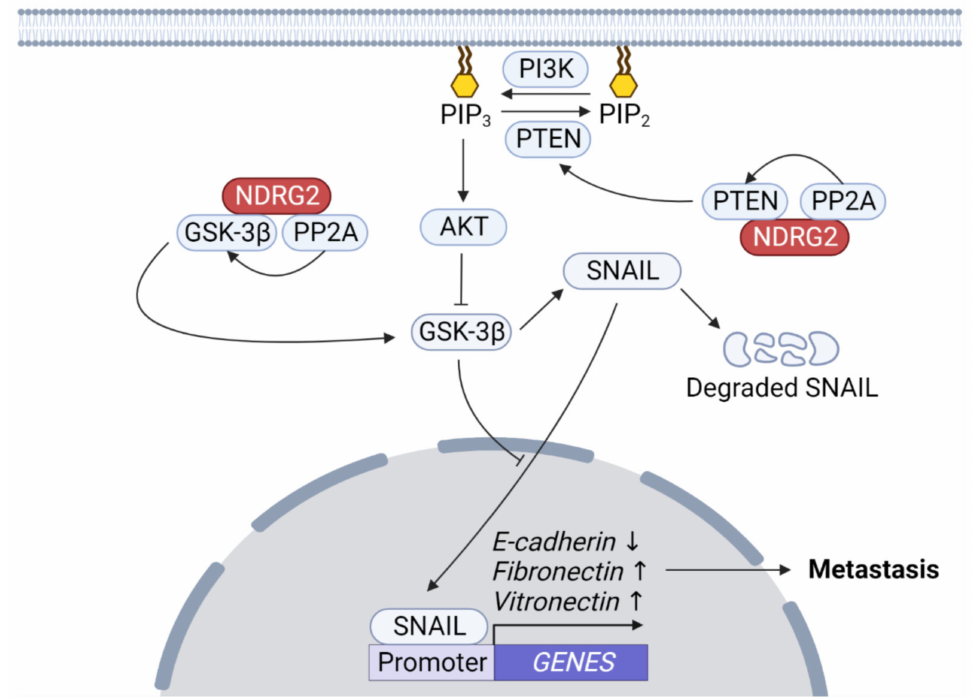
Figure 5. NDRG2–PP2A-mediated GSK-3 β activation. AKT induces inhibitory phosphorylation of glycogen synthase kinase-3 beta (GSK-3 β ). The NDRG2–PP2A complex recruits PTEN, which dephosphorylates PIP3 to inhibit AKT activation. Further, the NDRG2–PP2A complex releases the inhibitory phosphate of GSK-3 β to activate it. Active GSK-3 β phosphorylates SNAIL to induce β -Trcp-mediated ubiquitination and degradation, which controls its subcellular localization. GSK-3 β activation downregulates EMT phenotypes, such as E-cadherin upregulation and fibronectin and vitronectin